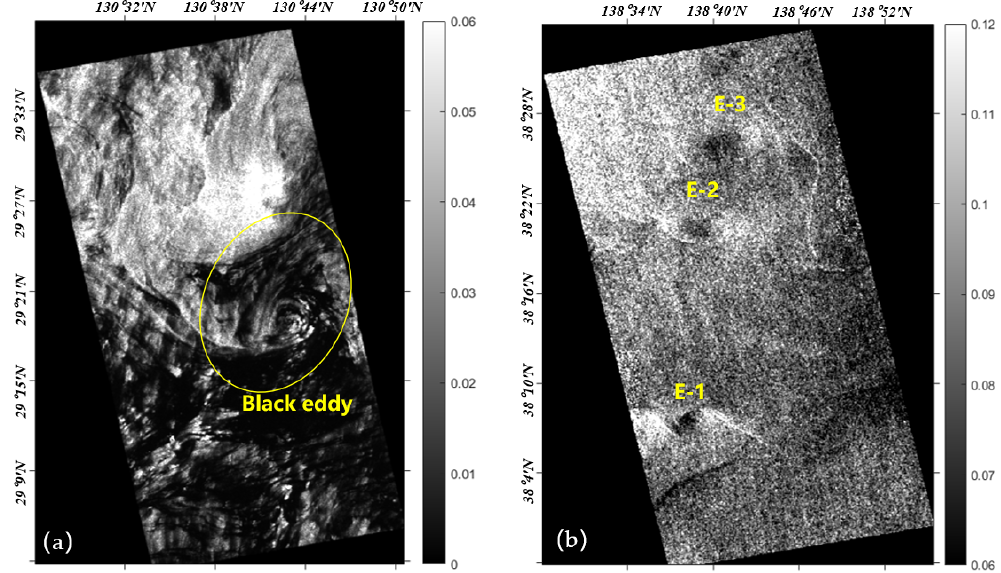
Figure 1. Two ALOS PALSAR VV-polarized backscattering coefficient images used in this study. ( a ) Data #A: white eddies ( W-E ) image containing three eddies: E-1 , E-2 , and E-3 . ( b ) Data #B: black eddies ( B-E ) image.